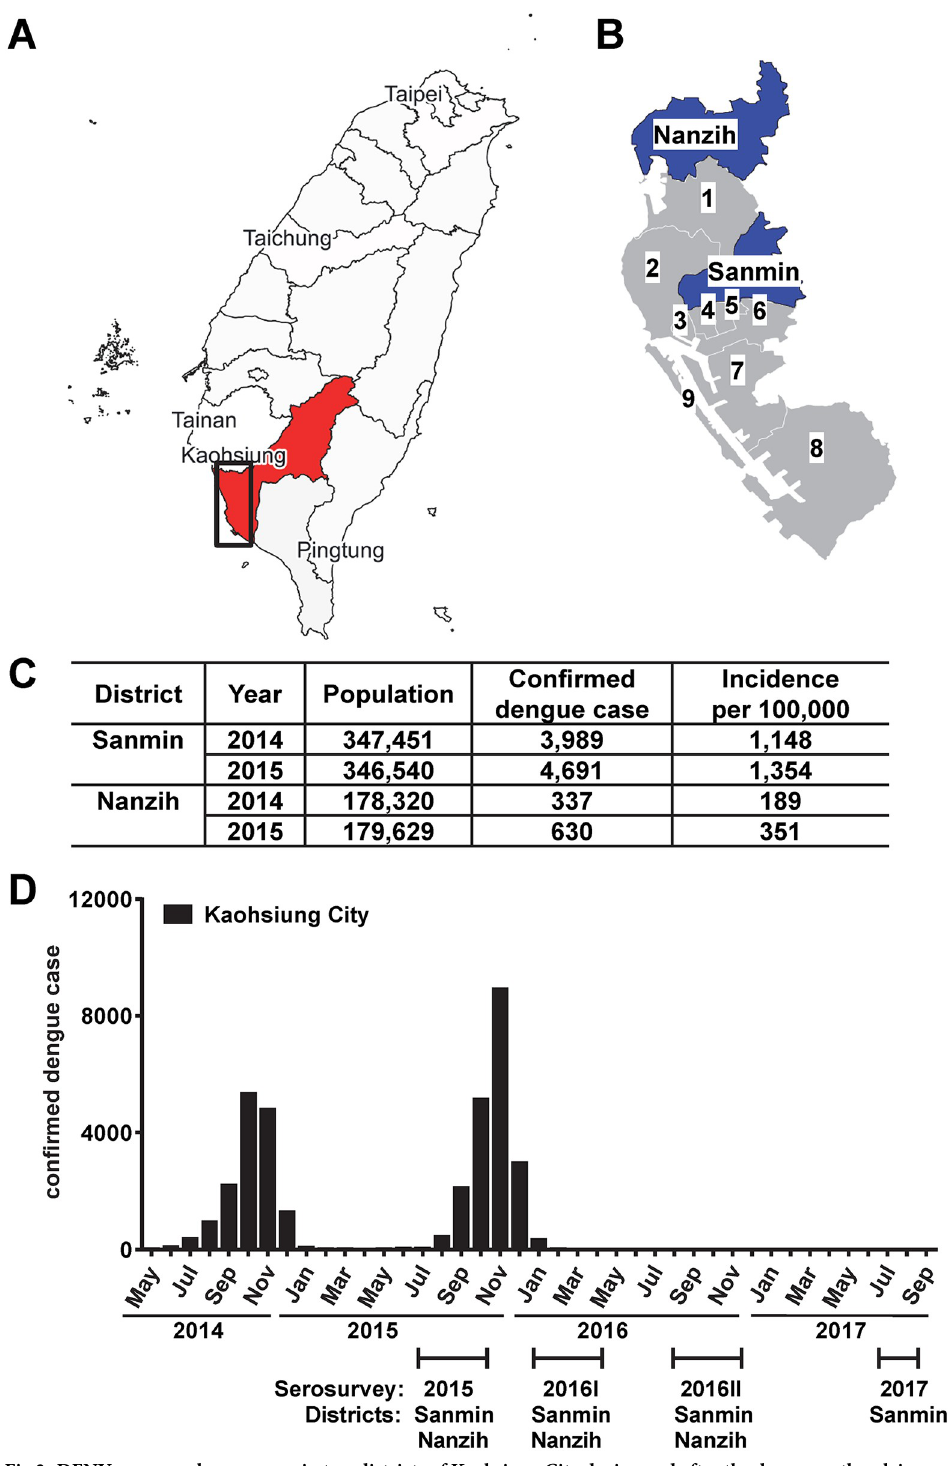
Fig 2. DENV seroprevalence survey in two districts of Kaohsiung City during and after the dengue outbreak in 2015. (A) Kaohsiung City is a metropolitan area in southern Taiwan. (B) Insert map of A: the Sanmin and Nanzih districts, together with other 9 districts, are located in the historic area of Kaohsiung City. (C) Population, confirmed indigenous dengue cases and incidence during the 2014 and 2015 outbreaks in the Sanmin and Nanzih districts [18,22]. (D) Study participants were enrolled at the beginning of the 2015 outbreak (2015) and during three periods after